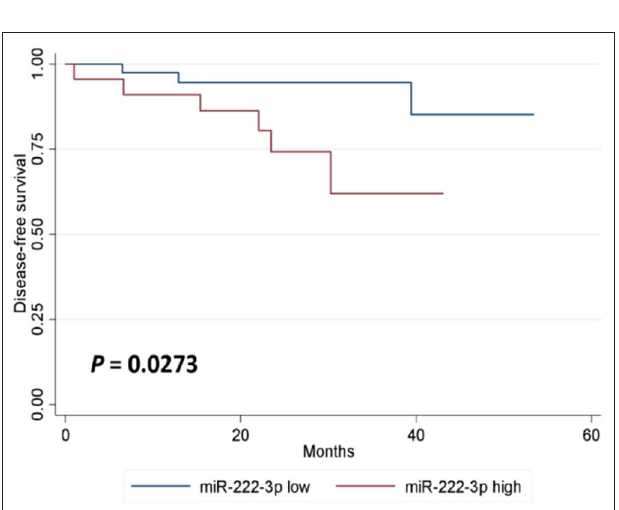
FIGURE 2 | Kaplan-Meier estimates of disease-free survival according to the expression of serum miR-222-3p.